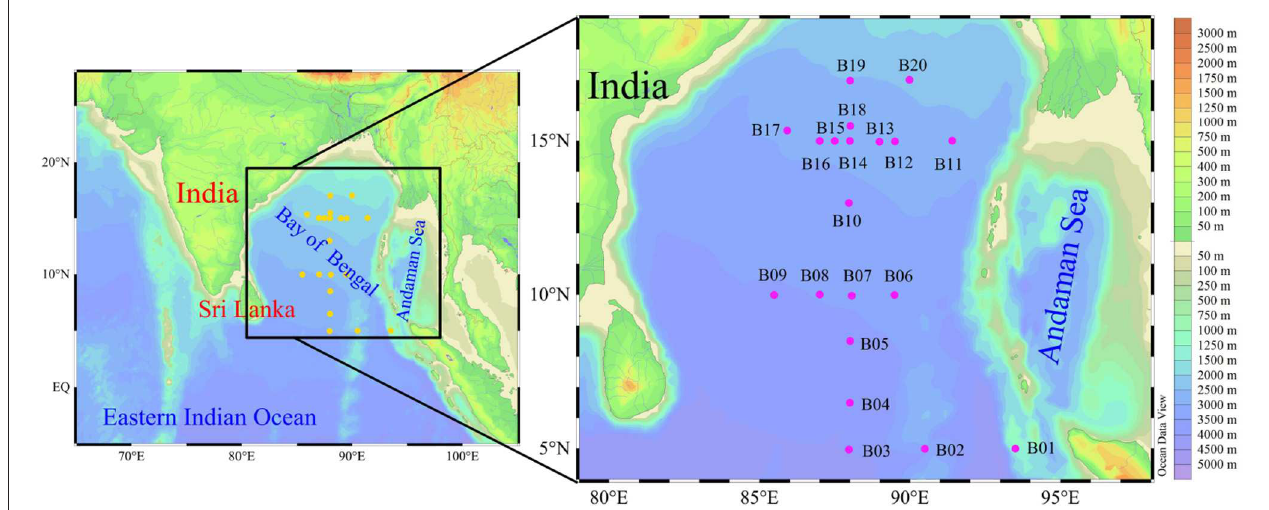
FIGURE 1 | Study area and sampling